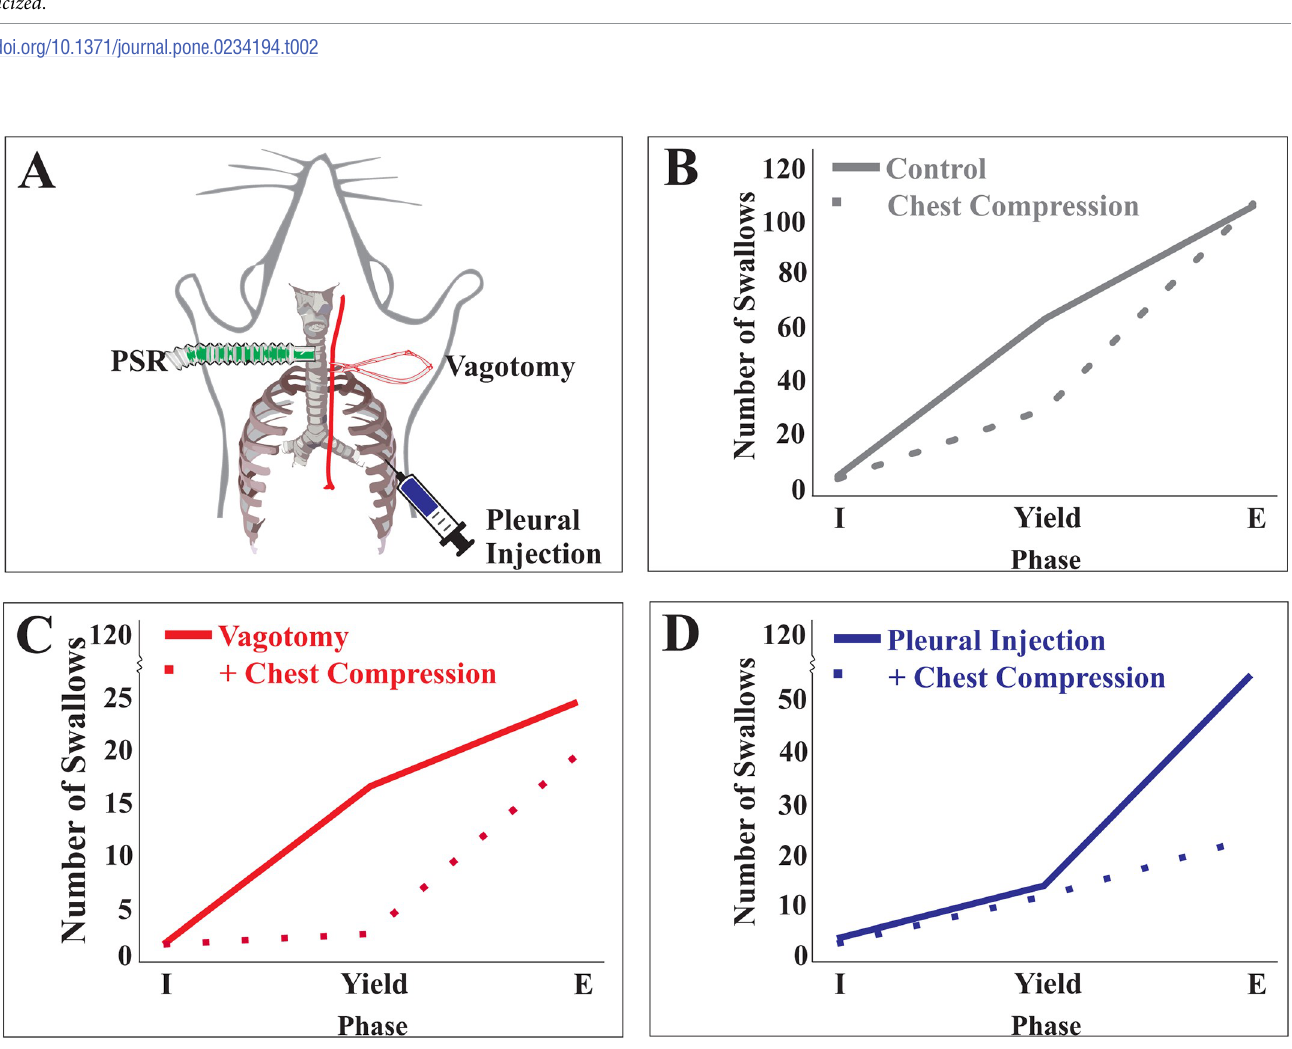
Fig 2. Experimental perturbations shifted swallow-breathing coordination in females. A) Illustrated representation of experimental protocol for afferent feedback manipulation. B) Chest compression shifted swallow-breathing coordination toward expiration, with swallow predominately occurring during expiration. In vagotomized females C), as well as those with reduced spinal feedback D), swallow-breathing coordination shifted toward expiration when chest compression was applied.